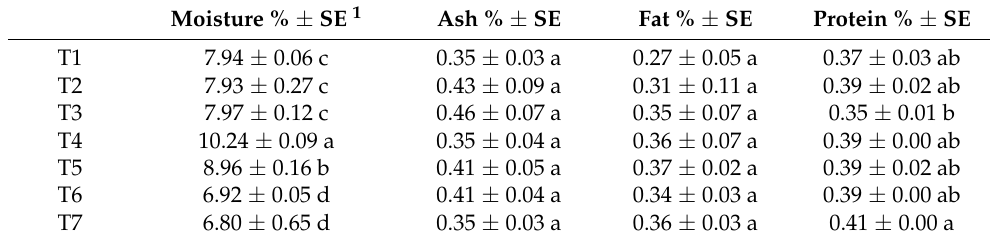
Table 7. Physicochemical properties of native corn starches.